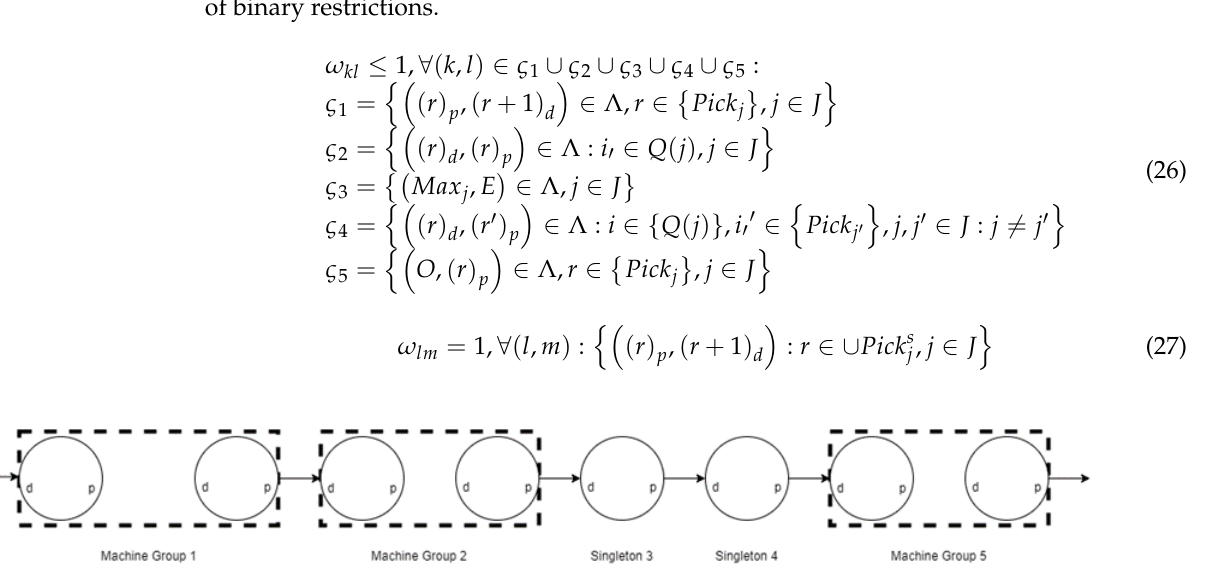
Figure 5. All possible p - d arcs combinations within each job between machine groups and machine groups (1 and 2), machine groups and singletons (2 and 3, 4 and 5), and inter-singletons (3 and 4). Constraints (28) and (29) apply to d and p nodes, respectively. The constituents of each node set forming directed arcs heading into and emanating from the node of interest depend on its respective node type.